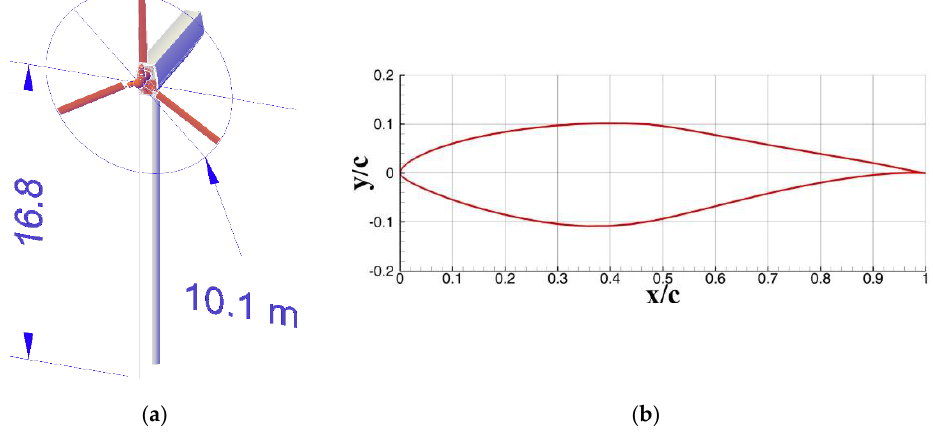
Figure 1. Grumman WS33 wind system [5,6]. ( a ) Schematic diagram. ( b ) Airfoil shape S809 [21]. The computational meshes were generated in a cylindrical domain. The longitudinal length and the diameter of the cylindrical computational domain were 10D (101 m, 1D = 10.1 m). The rotor was placed on the central axis of the cylindrical space at the location 3D (30.3 m) behind the flow entrance surface. Furthermore, the computational domain was divided into two subdomains to save computer resources and reduce the computing time. Meanwhile, the dynamic meshes were assigned in the inner subdomain near the rotor. The inner subdomain diameter was 1D, and the longitudinal length was 4D (1D in front of the rotor and 3D behind). The fixed meshes were assigned to the outer subdomain. A schematic diagram of the computational domain is presented in Figure